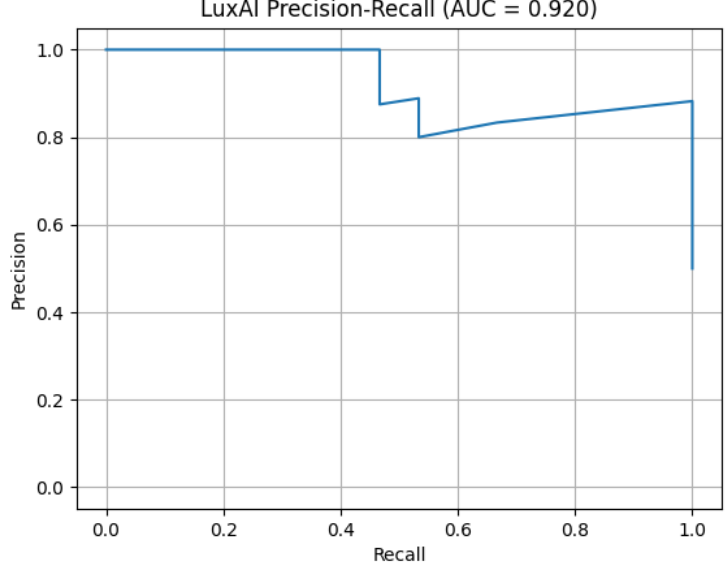
Figure 10. Precision vs. recall for man-in-the-middle attack.